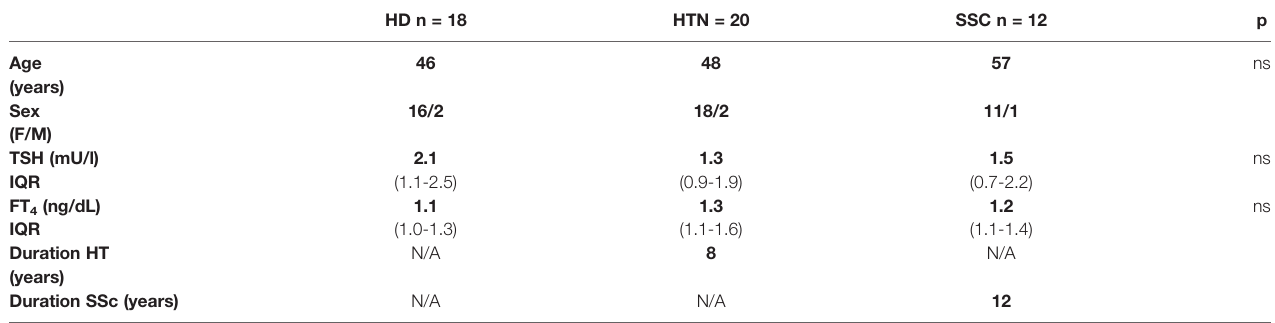
The results are expressed as median values